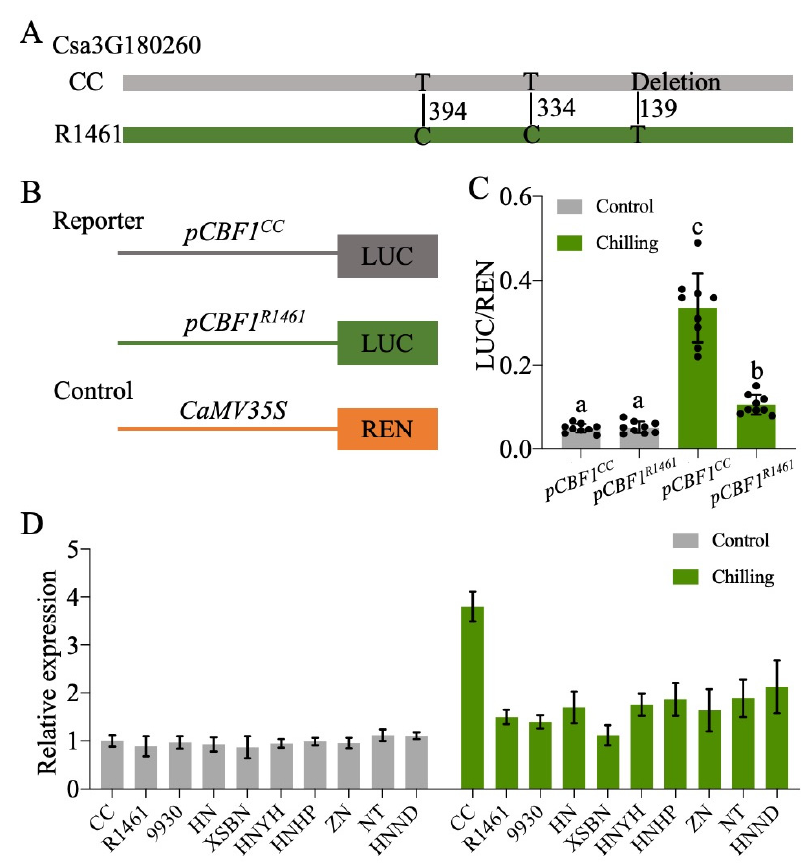
Figure 5. Association of natural polymorphisms in the promoter region of CBF1 with chilling responses. ( A ) Sequence variations of CBF1 in CC and R1461. Positions were defined relative to the transcription start site of CsCBF1 . ( B ) Schematics of the reporter and control constructs used in the dual-luciferase expression assay. LUC, Firefly luciferase; REN, Renilla luciferase. ( C ) Effects of the polymorphisms on the activity of the CBF1 promoter. pCBF1 CC ::LUC and pCBF1 R1461